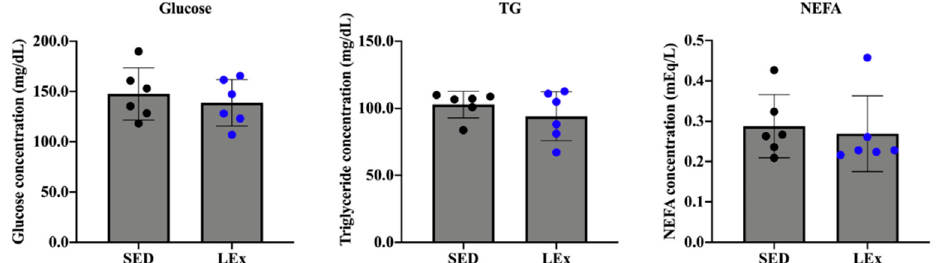
Figure 3. Effects of acute exercise on the concentrations of plasma glucose, TG, and NEFA. TG: triglycerides, NEFA: non-esterified fatty acids, SED: sedentary group ( n = 6). LEx: low-intensity exercise group ( n = 6).